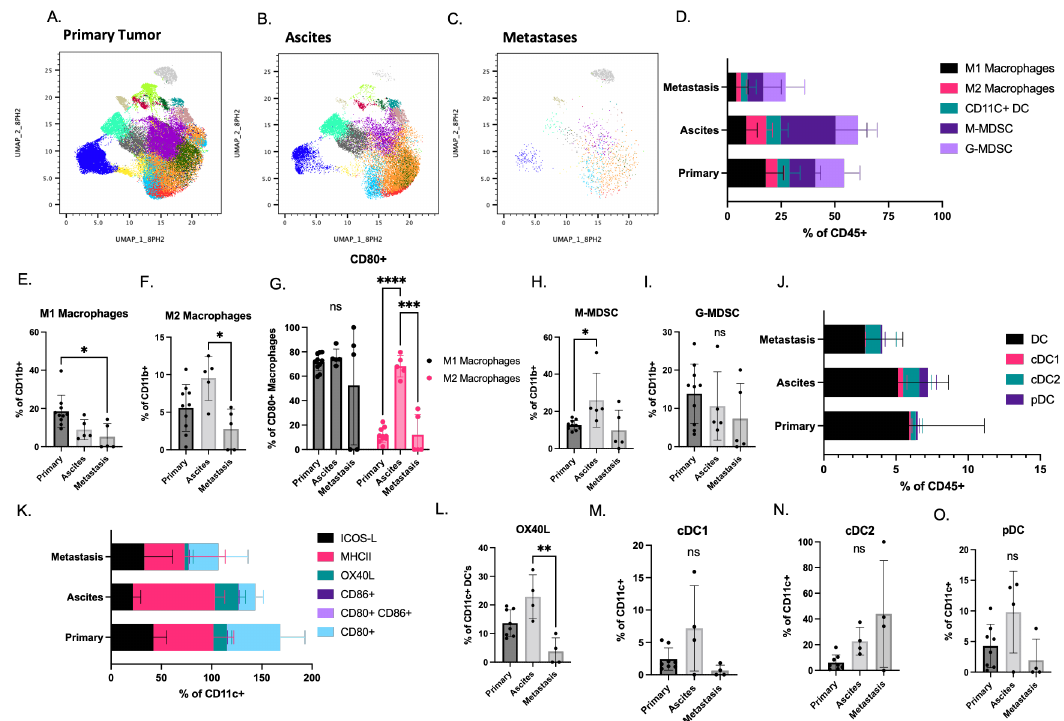
Figure 4. Myeloid cell profiling of immune cells isolated from different sites in the STOSE.M1 luc murine ovarian intrabursal cancer model: ( A – C ) UMAP plots overlayed with FlowSOM (Flow self- organizing map) of tumor infiltrating immune cells (CD45 + ) isolated from STOSE.M1 luc ovarian intrabursal model, propagated in FVB/NJ mice. Clustering was based on expression profiles of myeloid cell surface markers. ( A ) Primary ovarian tumors ( n = 10). ( B ) Ascites ( n = 5). ( C ) Metastases ( n = 5). Each dot represents an individual cell. ( D ) Myeloid cells as a % of CD45 + immune cells in